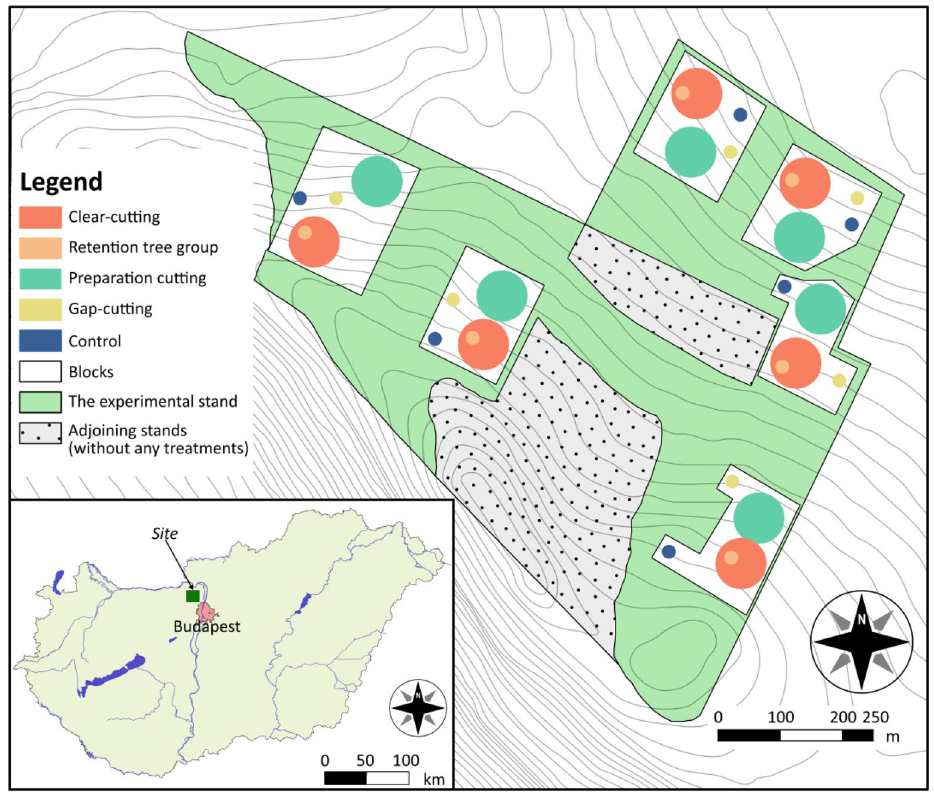
Figure 6. Overview of the experimental setup depicting the whole stand, the six replicate blocks and the treatment areas within the blocks. Treatments are colour coded according to